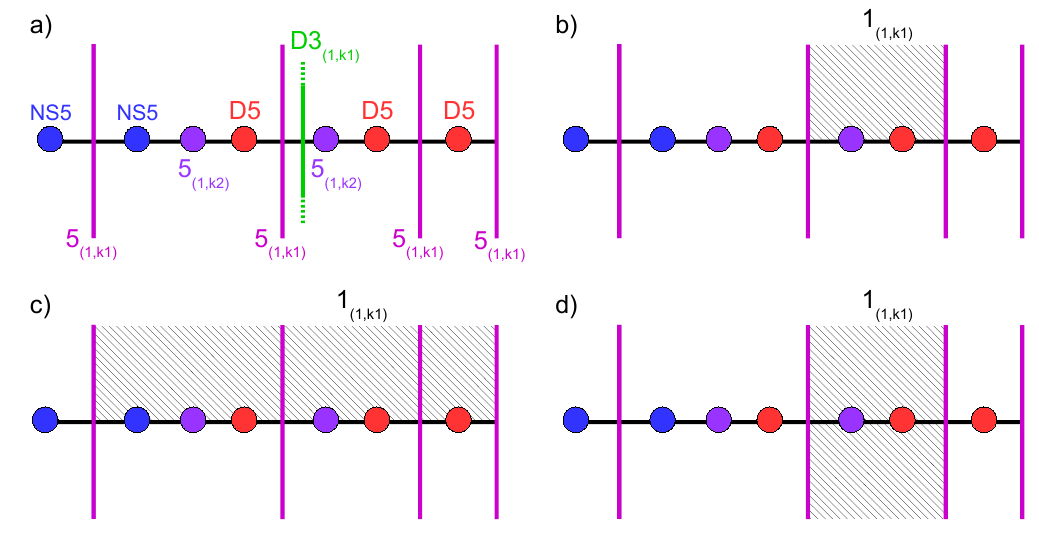
Figure 30 . Setups realizing the insertion of some branch IV operators: (a) X IV; 2 , (b) v + V + ), and setups for the chiral ring relations (c) V + [2 ; 3] V + V (cid:0) = ( ’ 4 (cid:0) ’ 5 )( X 5 ) j k 1 (cid:0) k 2 j ’ 6 ( ’ 7 (cid:0) ’ 6 [2 ; 3] [2 ; 3]